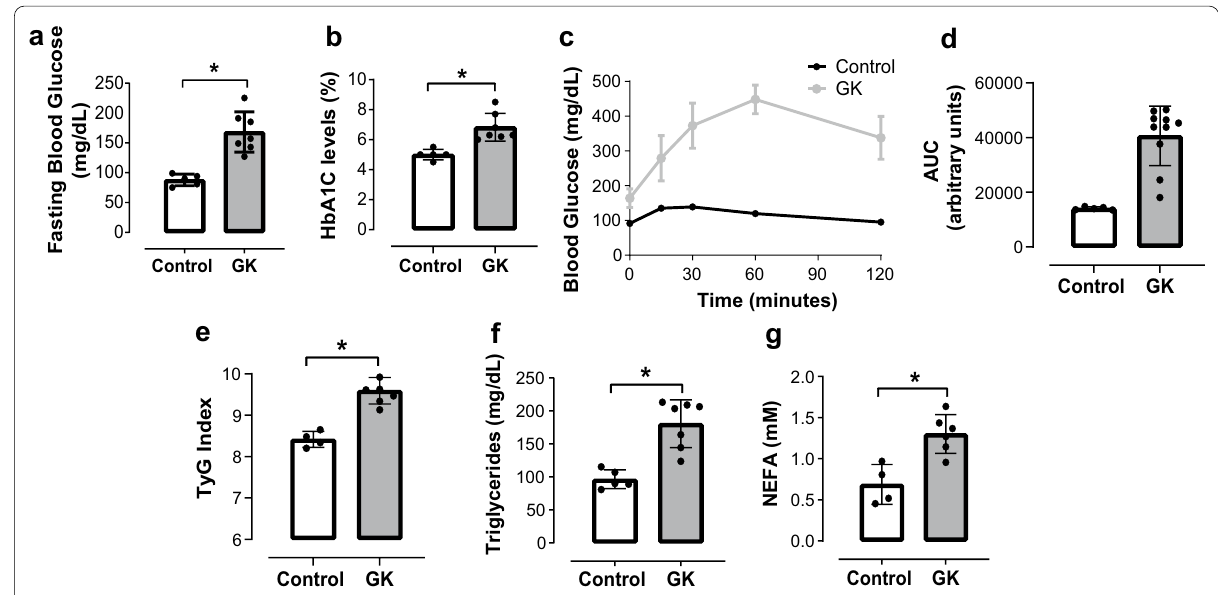
Fig. 1 Altered glucose metabolism, insulin sensitivity and lipid profile from GK rats in advanced T2DM. a Fasting blood glucose (mg/dL), b HbA1C levels (%), c Oral glucose tolerance test (oGTT) performed during 120 min after administration of glucose (2 g/kg body weight), d Total blood glucose accumulation reported as area under the curve (AUC), e TyG Index (insulin sensitivity marker), f Fasting triglycerides (mg/dL), g Non‑esterified fatty acids (NEFA) (mM) of male GK rats. *p < 0.05 vs. control, n 5–7 per group. Values are means = ±